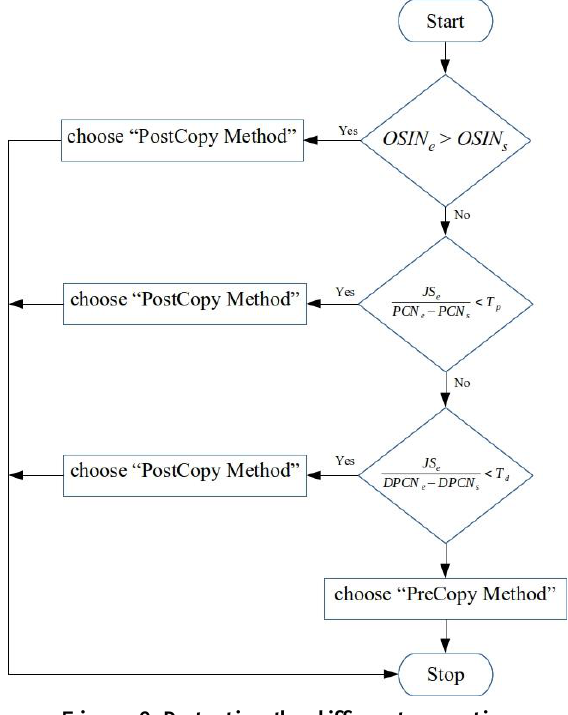
Figure 9. Detecting the different operating conditions of a virtual